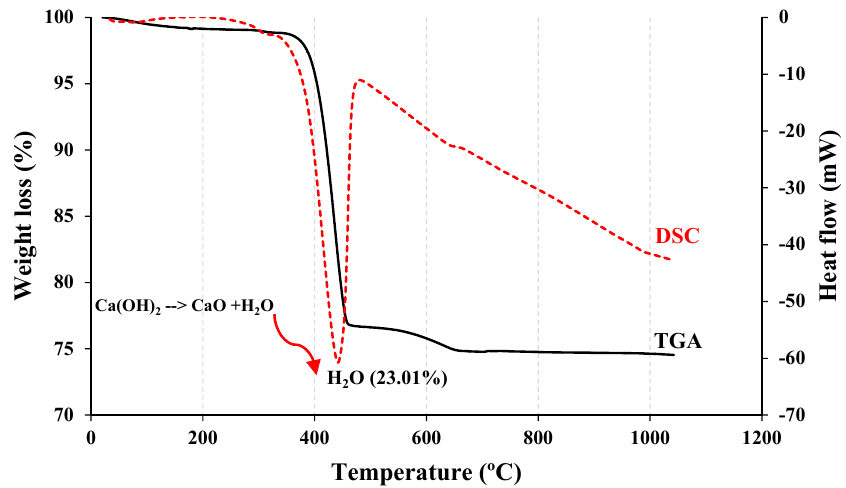
Figure 6. FT − IR of lime, NP1, NP2, and GSF powders.